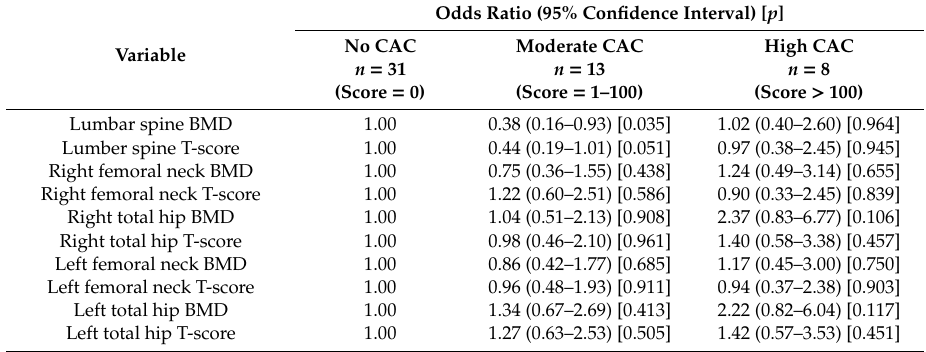
Table 5. Multinomial logistic regression analysis of the association of BMD and T-score with CAC in patients with